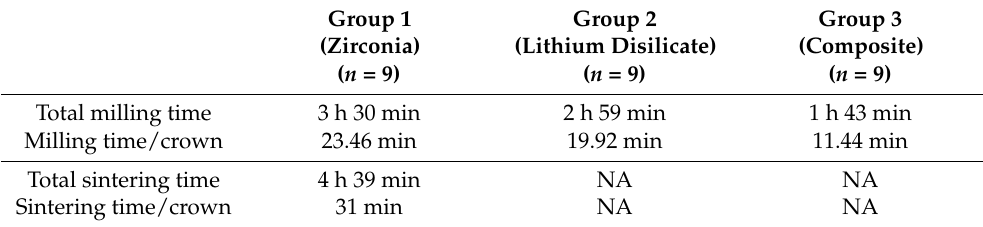
Table 3. Time of crown